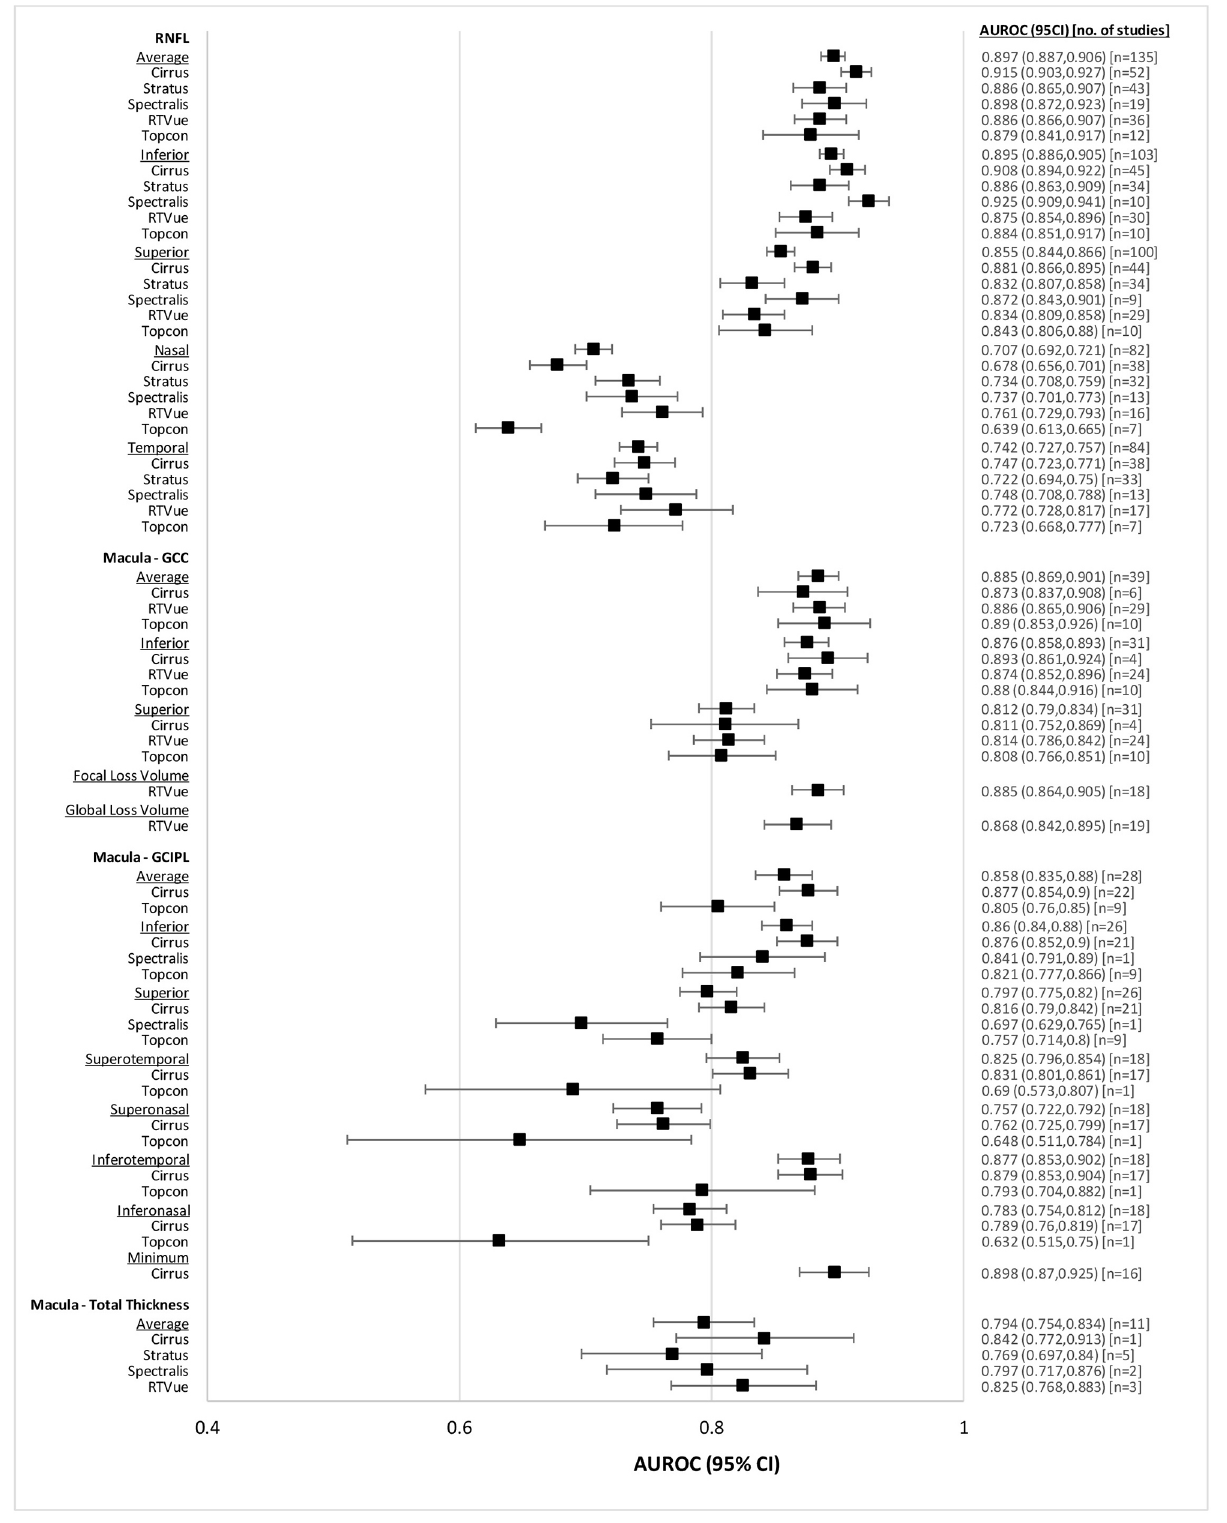
Fig 3. Forest plot of diagnostic accuracies of RNFL and macular OCT parameters,all glaucoma patients.